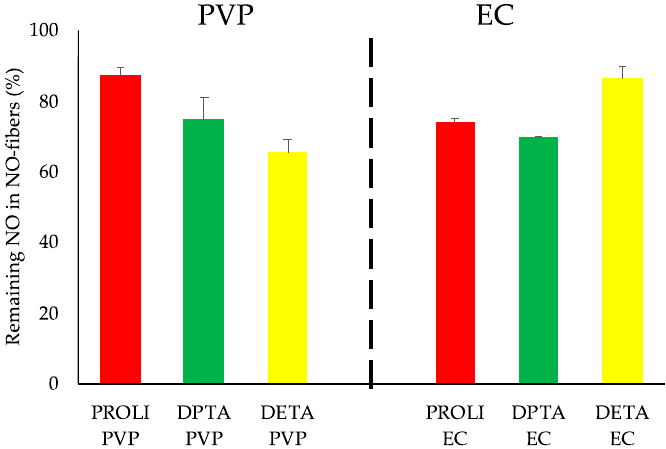
Figure 6. The evaluation of the long-term stability of NO-fibers after 12 months. The total NO contents from NO-fibers were compared to the total NO contents measured 12 months prior and presented in percentage. DETA-PVP NO-fibers showed the greatest loss of NO while PROLI-PVP NO-fibers and DETA-EC NO-fibers showed the highest retention of the initial NO contents over 12 months storage. n = 3 data is shown as mean ± SD.